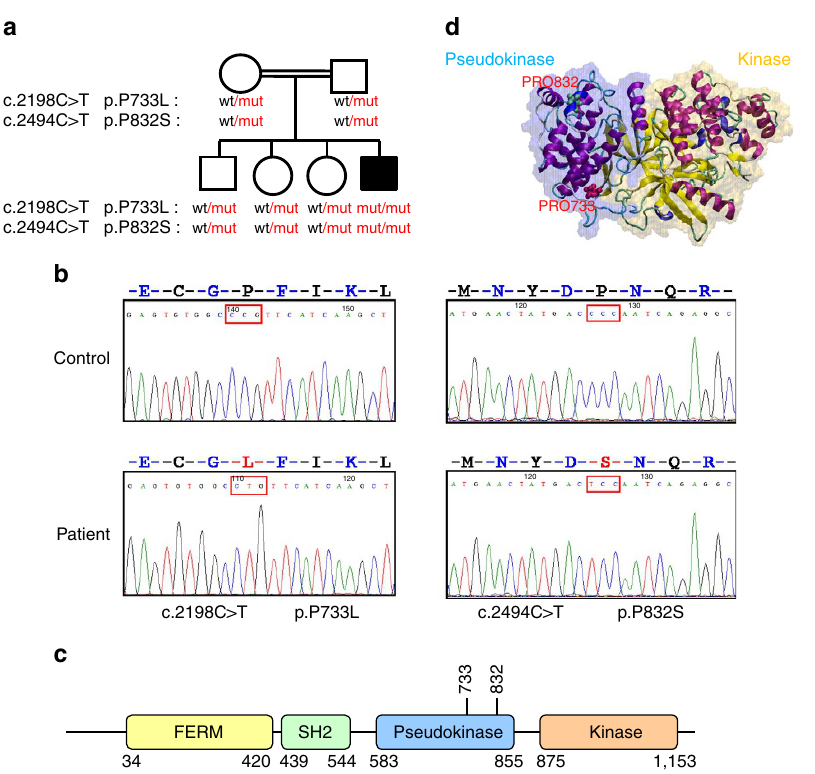
Figure 1 | Two JAK1 mutations found in the patient. ( a ) Patient’s family tree. ( b ) Sequence chromatograms showing two mutations in the JAK1 gene. ( c ) Domain structure of the JAK1 protein. ( d ) JAK1 pseudokinase (JH2) and kinase (JH1) domains modelled using the published structure of TYK2 pseudokinase and kinase domains (PDB 4OLI). Pro733 and Pro832 are shown in red and green,